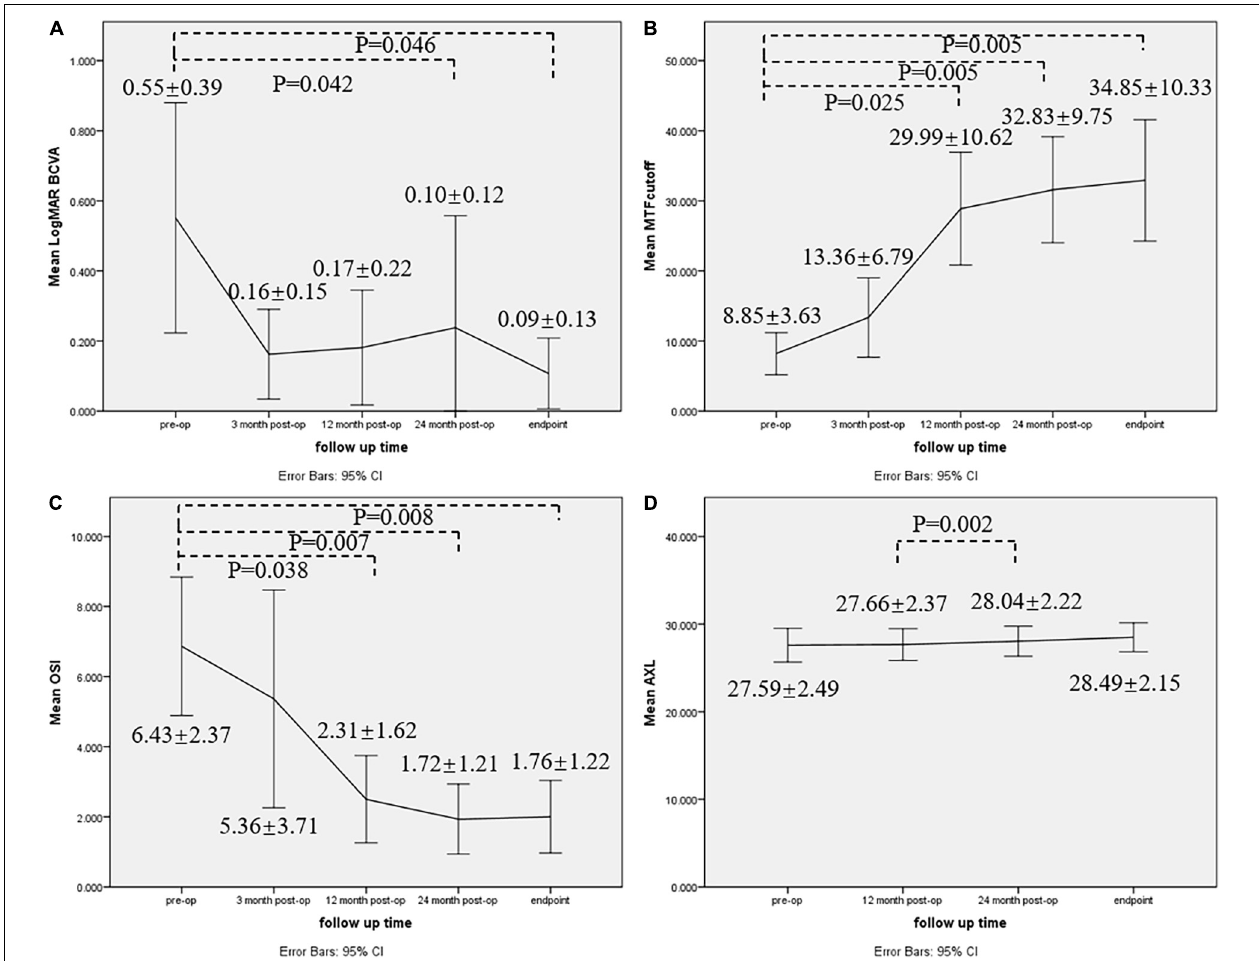
FIGURE 2 | Line graph showing preoperative and postoperative comparisons for (A) LogMAR BCVA, (B) MTF cutoff , (C) OSI, and (D) AXL. Mean ± SD of each parameter was shown, and P -value was displayed if the change was significant ( P < 0.05). BCVA best-corrected visual acuity, AXL axial length, MTF cutoff modulation transfer function cutoff frequency, OSI objective scatter